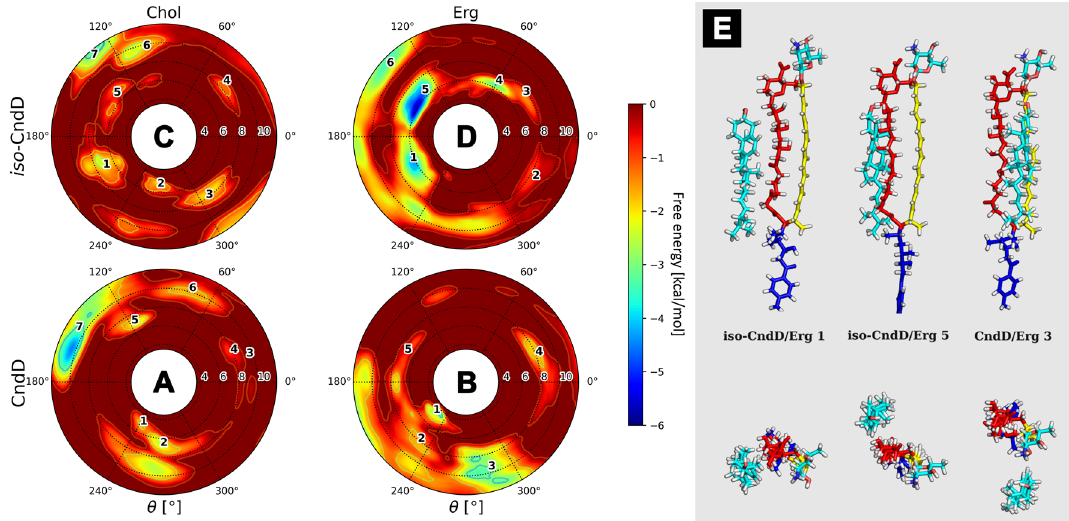
Figure 3. Free energy landscapes, calculated for candicidin D (panels A & B ) and iso-candicidin D (panels C & D ). Panel ( E ) contains representative structures of the (iso-)CndD/sterol complexes, extracted from selected energetic minima via cluster analysis. Number of a structure corresponds to the respective energetic minimum of a given system. Panel ( E ) colours: red—antibiotic’s polyol region; yellow—antibiotic’s heptaene chromophore; dark blue—alkyl-aromatic side chain; light blue—sterol molecule.